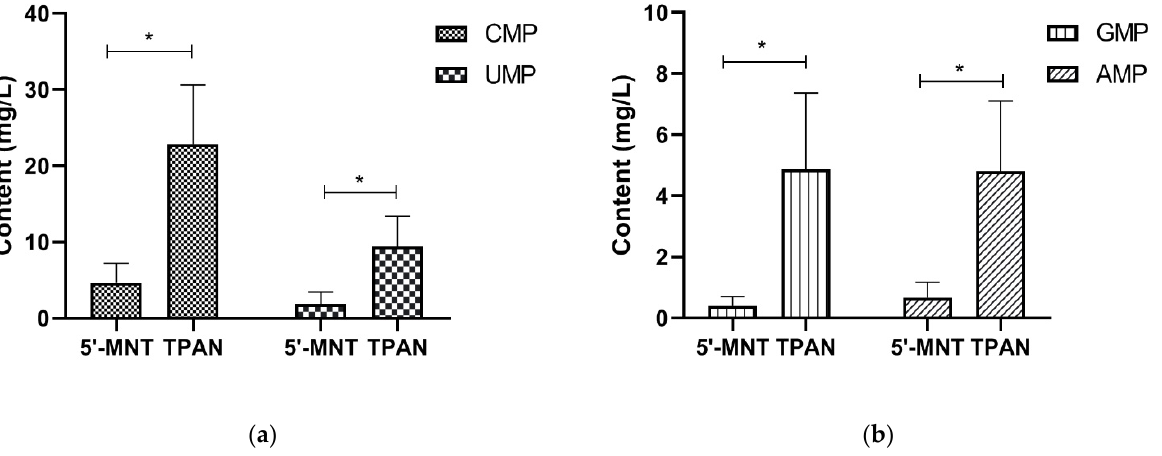
Figure 1. Comparison of 5 ′ -MNT contents and TPAN contents in human milk. ( a ) Comparison of pyrimidine nucleotide contents in 5 ′ -MNT and TPAN; ( b ) Comparison of purine nucleotide contents in 5 ′ -MNT and TPAN. CMP, Cytidine monophosphate; UMP, uridine monophosphate; GMP, guanosine monophosphate; AMP, adenosine monophosphates; 5'-MNT, free 5'-monophosphate nucleotides; TPAN, total potentially available nucleosides. * Indicates p < 0.05.